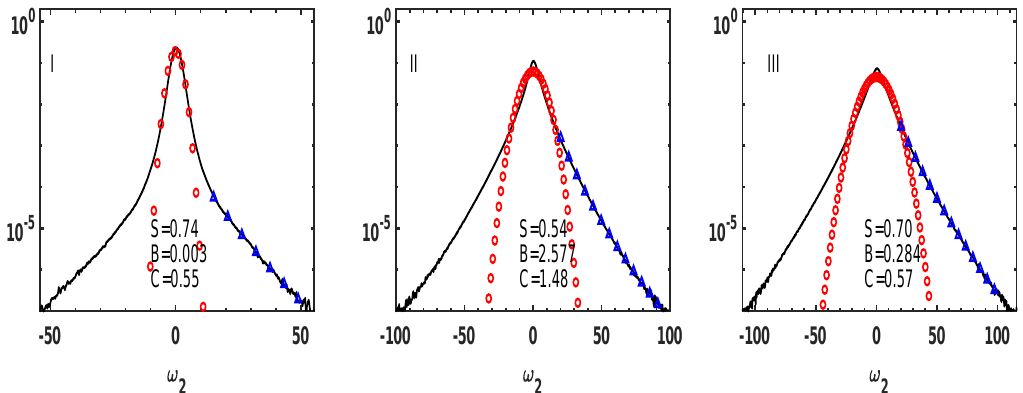
Figure 2. PDFs of one horizontal component of vorticity, ω 2 ( left ), and of ω (see insets for bin values). We observe larger wings at intermediate values of Fr (0.007 < Fr peak of K W in Figure 1.